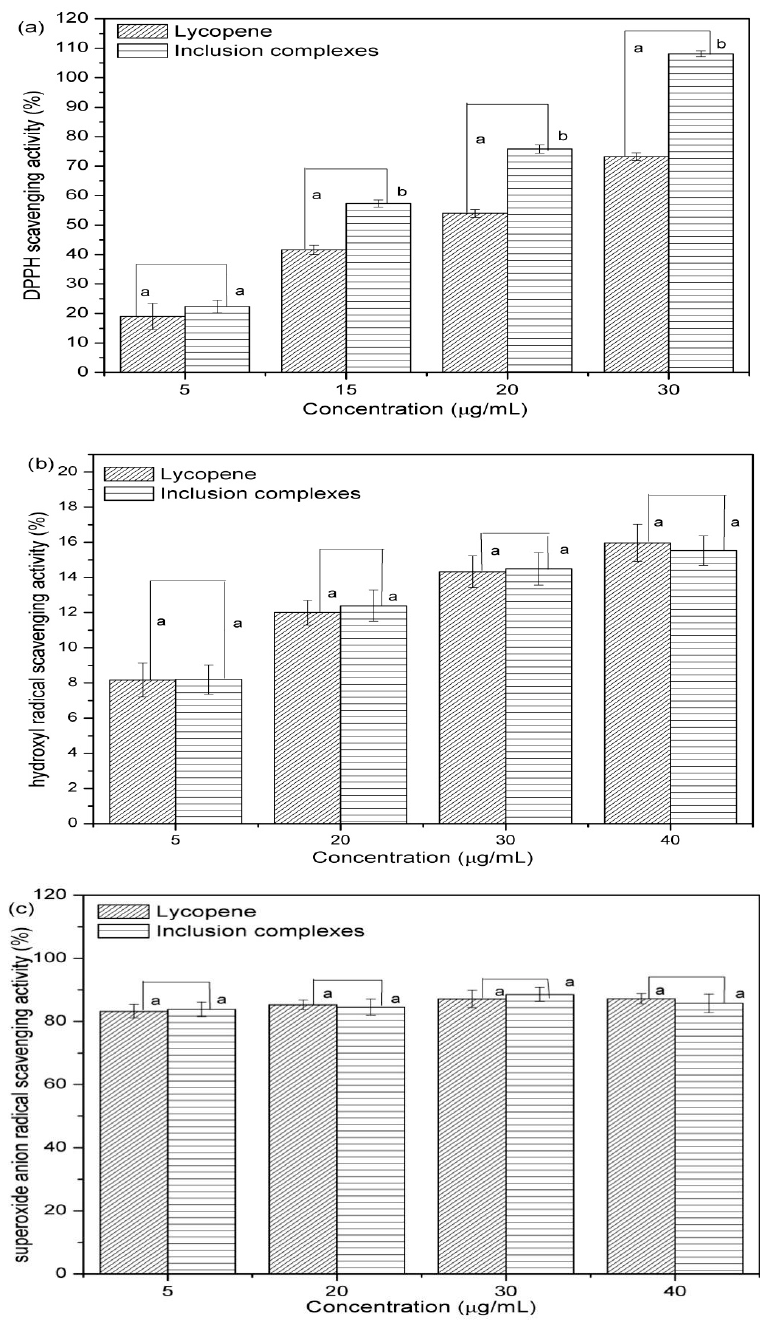
Figure 6. Antioxidant activity of the lycopene and inclusion complexes: ( a ) DPPH scavenging activity; ( b ) hydroxyl scavenging activity; ( c ) superoxide anion radical scavenging